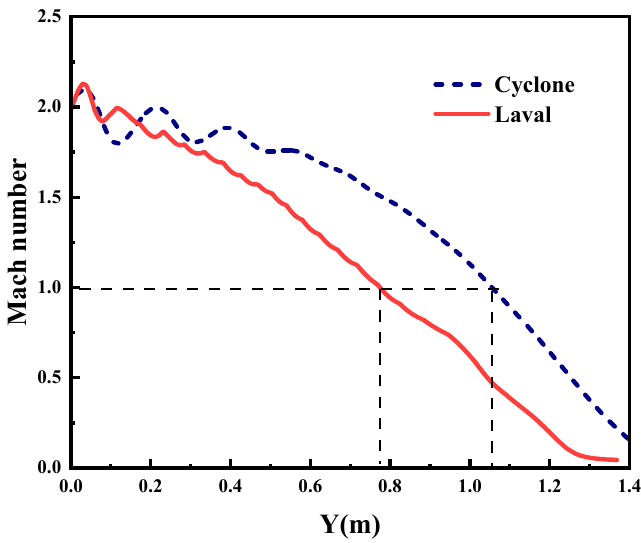
Figure 9. Comparison of Mach number between Laval and cyclone oxygen lances (lance height 1100 mm, operation pressure 0.8 Mpa).